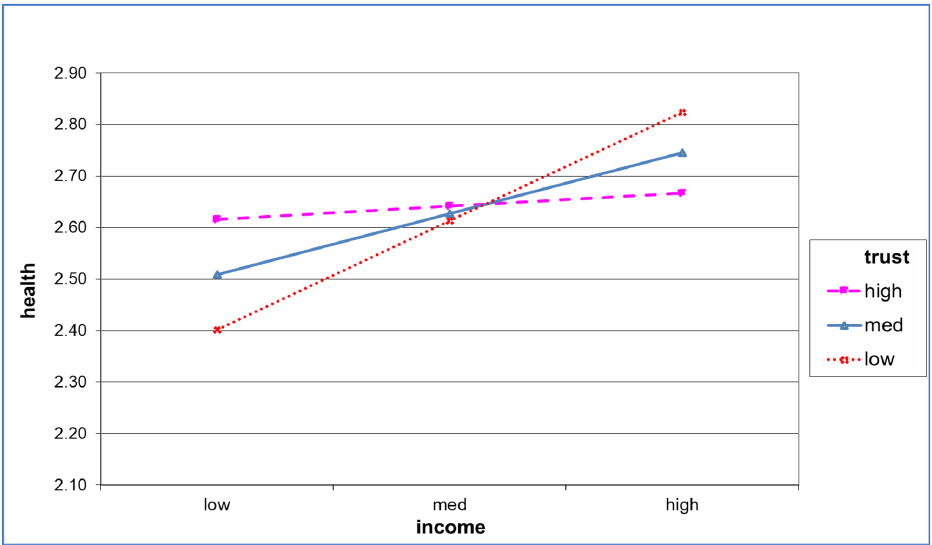
Figure 1. The moderating effect of